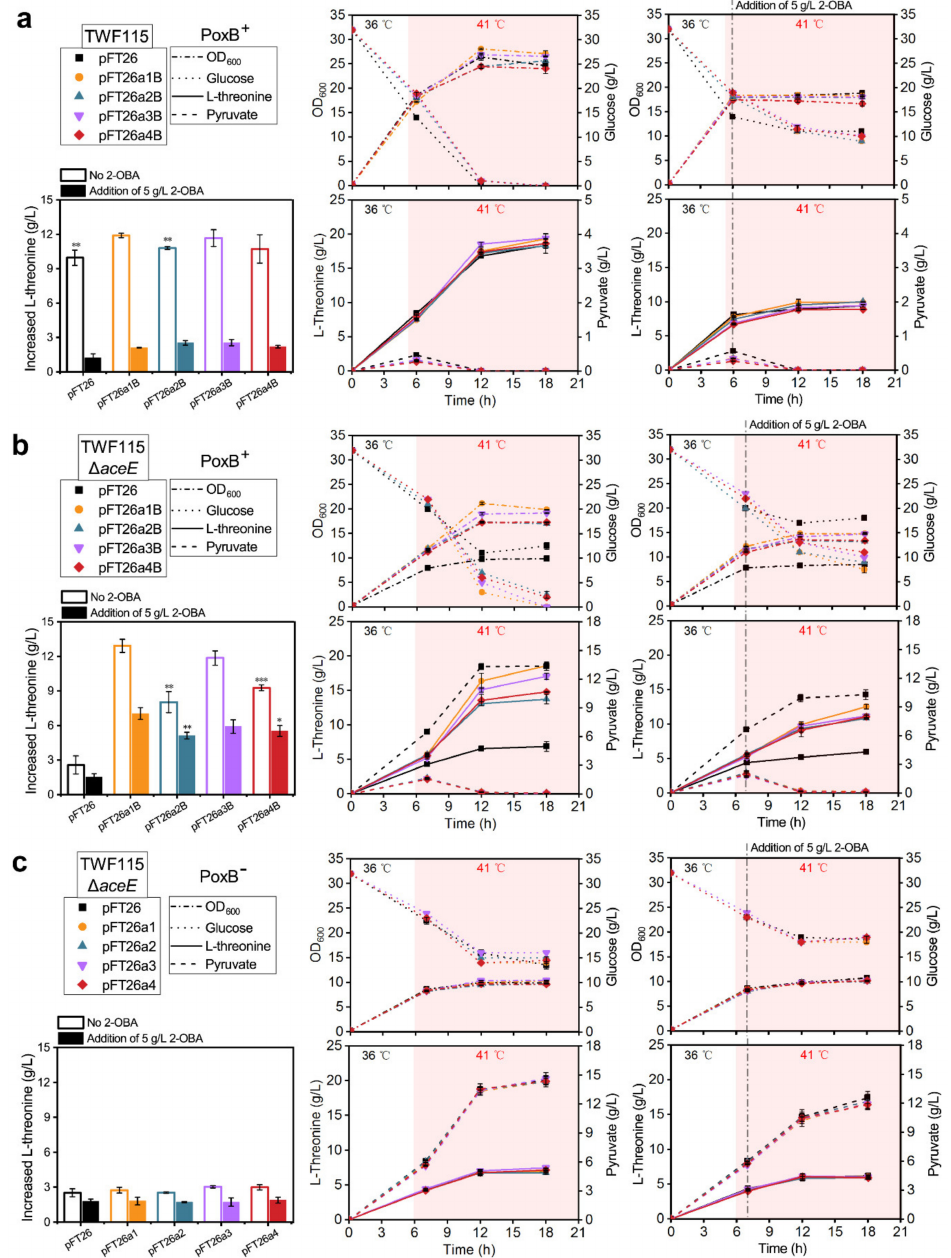
Figure 2. Effects of 2-OBA addition on cell growth (OD 600 ), glucose consumption, L -threonine biosynthesis and pyruvate metabolism in different recombinant E. coli strains. ( a ) The fermentation of strains TWF115 harboring pFT26, pFT26a1B, pFT26a2B, pFT26a3B and pFT26a4B. The time-point of temperature shift from 36 ◦ C to 41 ◦ C was set at 5 h. ( b ) The fermentation of host strain TWF115 ∆ aceE harboring pFT26, pFT26a1B, pFT26a2B, pFT26a3B and pFT26a4B. The time-point of temperature shift from 36 ◦ C to 41 ◦ C was set at 6 h. ( c ) The fermentation of host strain TWF115 ∆ aceE harboring pFT26, pFT26a1, pFT26a2, pFT26a3 and pFT26a4. The time-point of temperature shift from 36 ◦ C to 41 ◦ C was set at 6 h. The time-point for 2-OBA (5 g/L) addition was set at one hour after the temperature shift. The increased L -threonine after the addition of 5 g/L 2-OBA was recalculated by subtracting the L -threonine secreted in the early stage of fermentation. Significance ( p -value) shown in ( a , b ) was evaluated by a two-sided t -test, compared to pFT26a1B. The s.d. is shown as black error bars. The two-tailed Student’s t -test was used for statistical analysis (*** indicates p -value < 0.001, ** indicates p -value < 0.01, * indicates p -value <